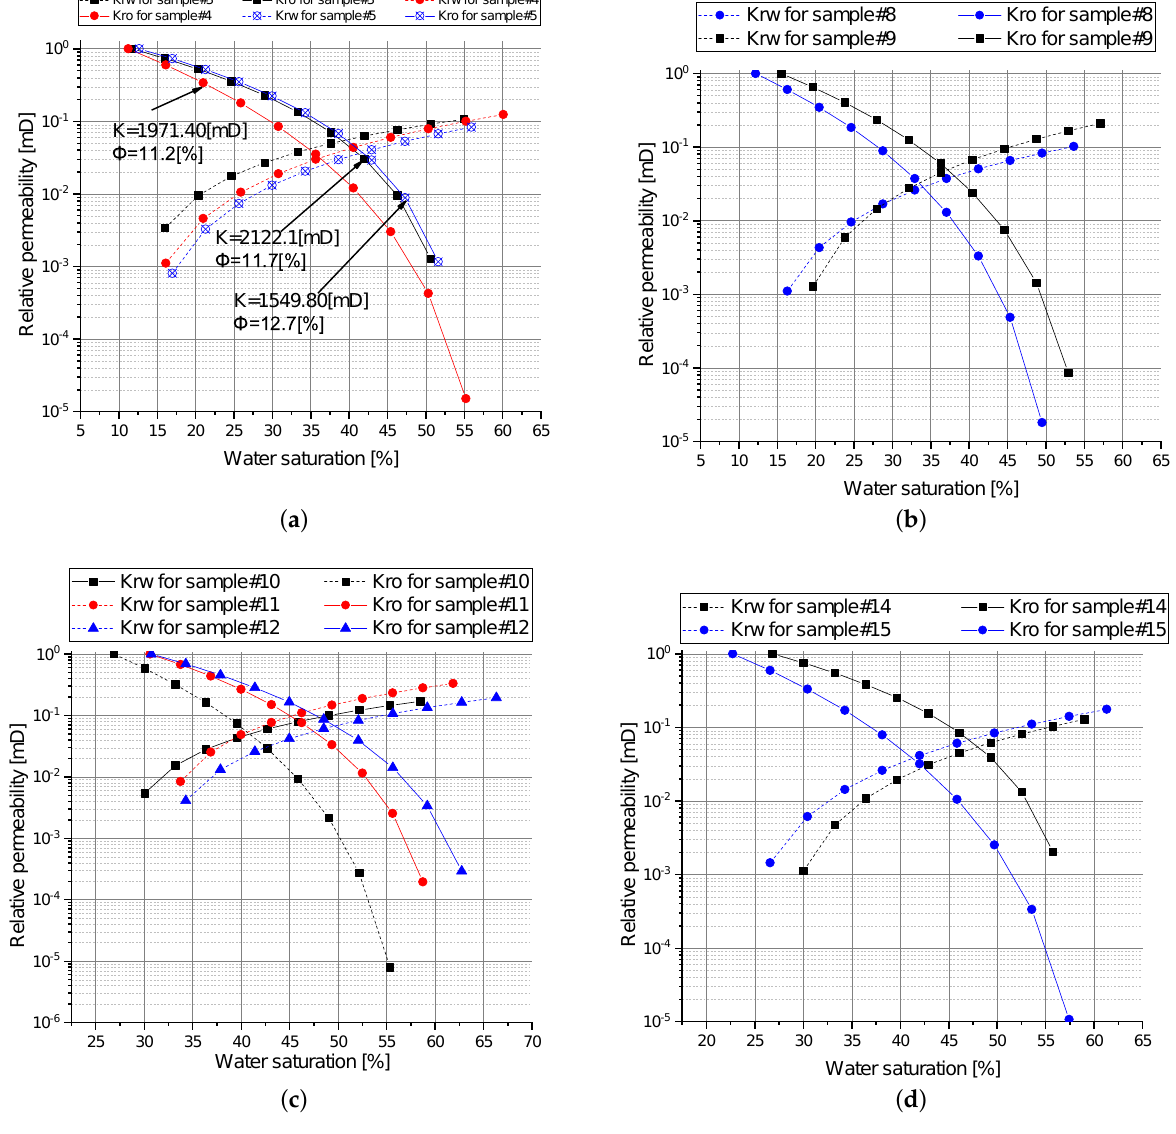
Figure 8. Relative permeability versus water saturation for oil wetting samples ( a , b ) and for water wetting samples ( c , d